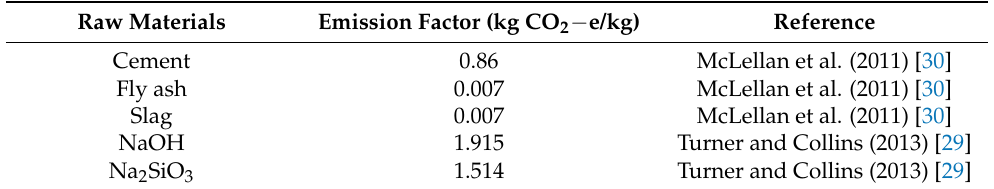
Table 8. Emission factors of raw materials.